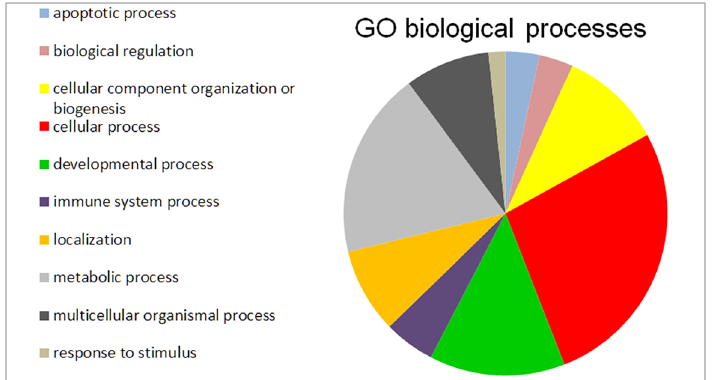
Fig 3. Gene ontology (GO) analysis of forty HD related genes identified from MetaCore. 1094 significant genes were analyzed using the MetaCore built-in HD pathway, and 40 HD-related genes were identified. These 40 genes were subjected to GO analysis, and the top ten GO biological processes are listed and shown in the pie